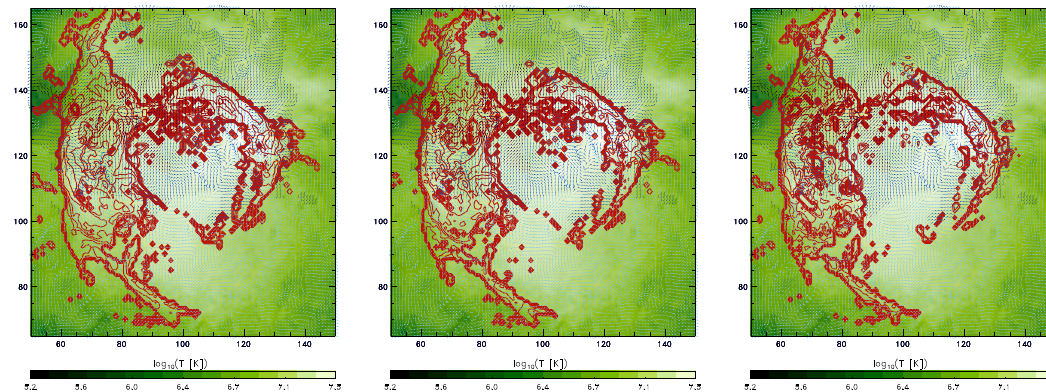
Figure 4. Isolated zoomed versions of our simulated radio relics. The green colours show the gas temperature. The blue arrows show the magnetic field. Their direction indicates the magnetic field direction and the colours give their magnetic field strength using a logarithmical stretching (as the brighter the blue the stronger the magnetic field). The red contours show the radio emission. The left panel shows the relics produced by all cosmic-ray electrons. The middle panel shows the relics produced by electrons that have been accelerated by quasi-perpendicular shocks only. The right panel shows the relics produced by electrons that have been accelerated by quasi-parallel shocks only. The axes are in d x = 31.7 kpc units.